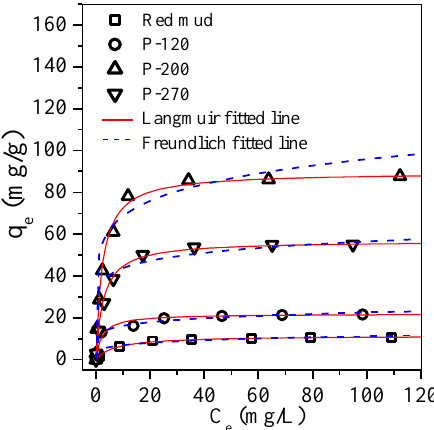
Figure 6. Adsorption isotherm of Zn 2 + on red mud, P-120, P-200, and P-270. Experimental conditions: equilibrium time: 12 h, P-200 dosage: 0.01 g, initial pH: 4. Table 1. Parameters of the isotherm models and the surface sites concentrations of red mud and the obtained adsorbents.